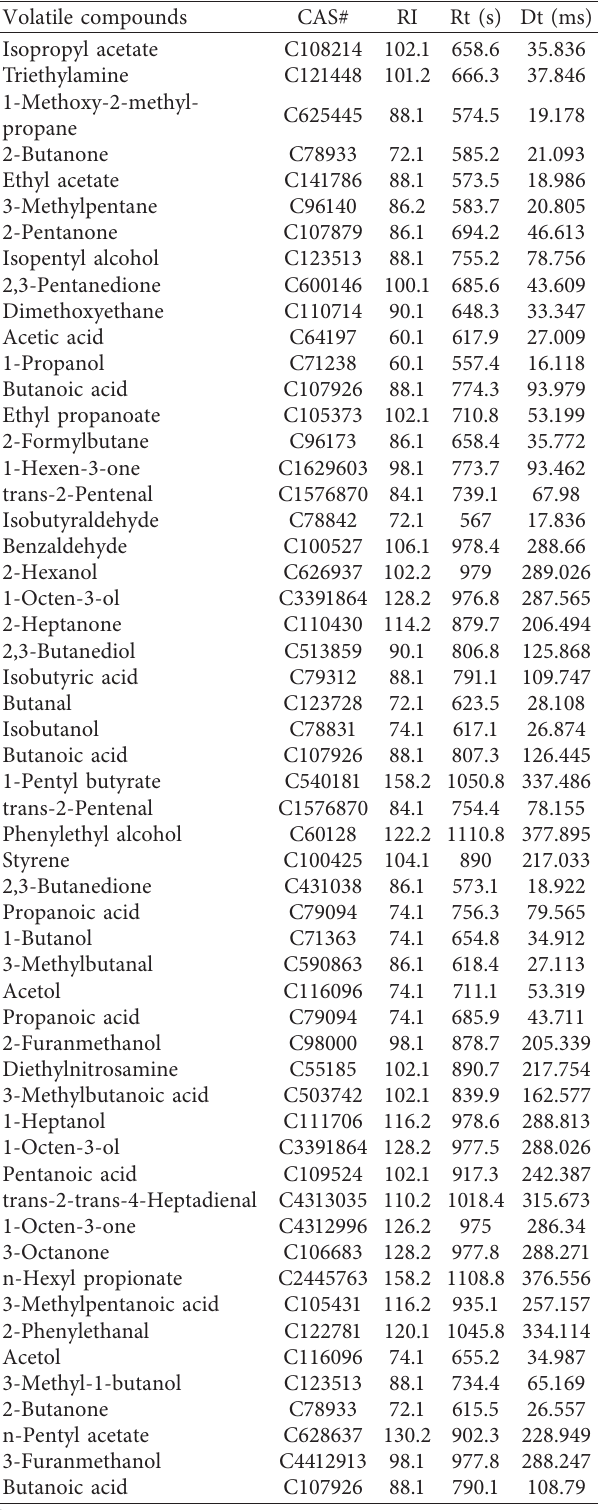
Table 4: The volatile compounds of steamed bread made from wheat flour †